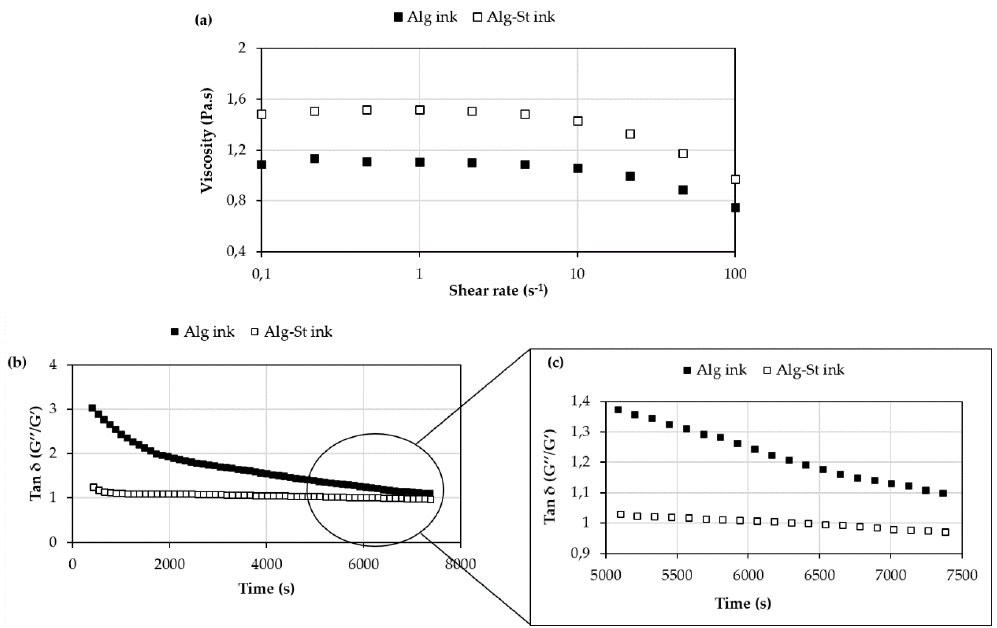
Figure 2. Evaluation of alginate-starch-based inks rheological properties, before ( a ) and during gelation ( b , c ).